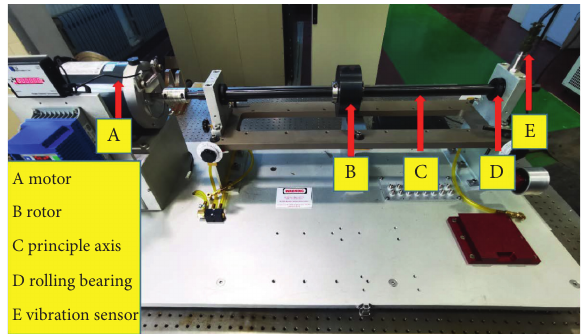
Figure 9: Comprehensive mechanical failure test bench. Table 1: Rolling bearing failure test